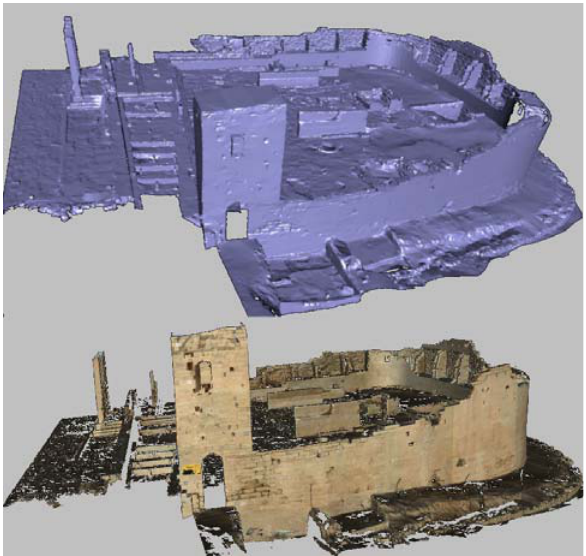
Figure 5. a) Triangle network derived from a CAD model Figure 4. Meshed 3D model of the Almaqah temple in (left); b) comparison of affine rectification (top) and projective Sirwah/Yemen (left) – automatically textured 3D model (right) (correct) rectification (bottom) of synthetic data; c) (Abdelhafiz 2009) determination of self-occlusion by ray tracing (centre) and corresponding original photograph